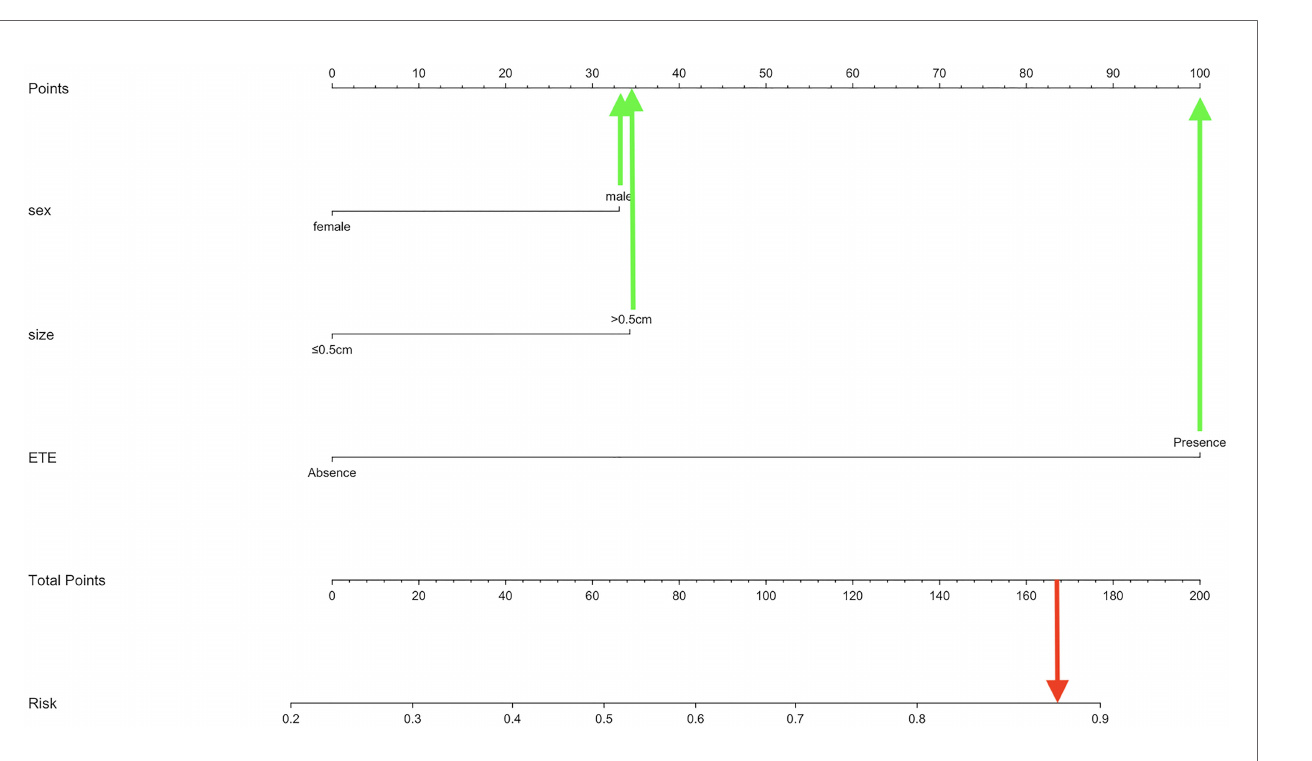
FIGURE 2 | Demonstration of the usage of our nomogram.